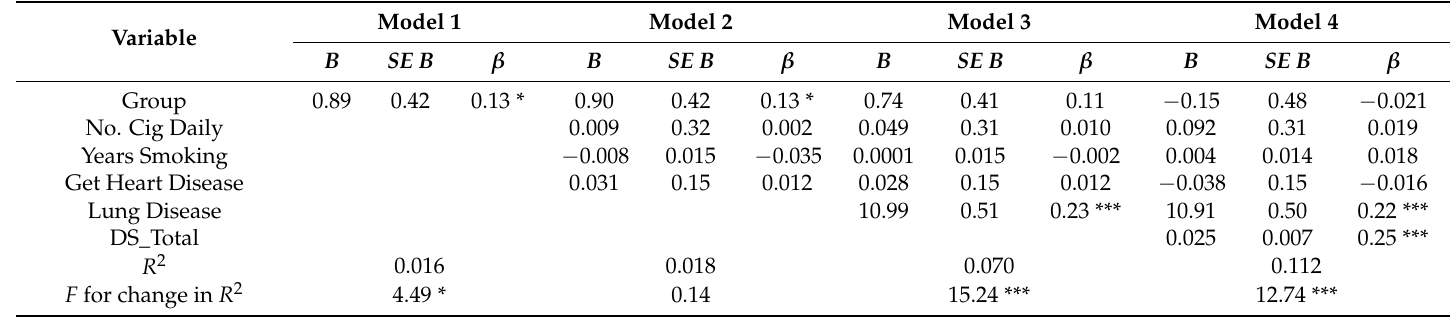
Table 4. Regressing DASS (DS) Symptoms, Number of Cigarettes Smoked Daily, Years of Smoking, Group, General Perception of Getting Heart Disease, and Presence of Lung Disease onto Respiratory